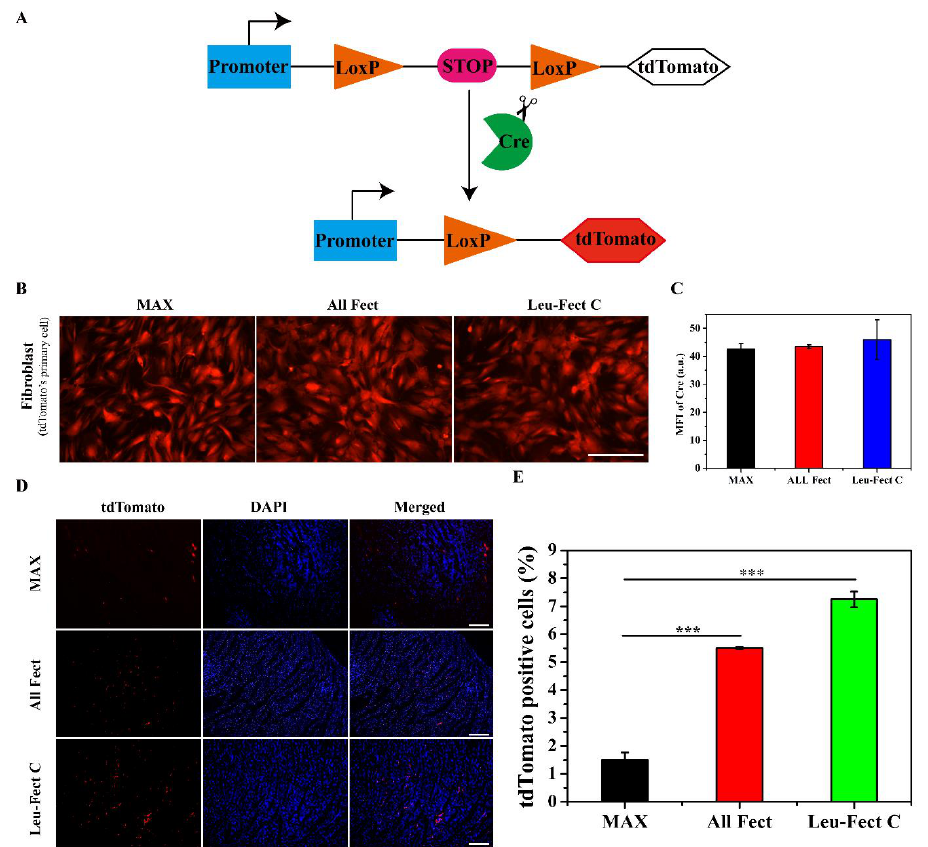
Figure 6. In vivo investigation of local organ injection of modRNA. ( A ) Cre/LoxP system working principle. ( B ) Fluorescent pictures of tdTomato expression following the transfection of Cre modRNA in primary mouse fibroblast cells (scale bar: 200 µm). ( C ) The mean fluorescence intensity of Cre modRNA expression of tdTomato in cells. ( D ) The fluorescent images of tdTomato expression levels in mouse hearts after 3 days of modRNA administration (scale bar: 200 µm). ( E ) Quantitative analysis of tdTomato-positive cell population in hearts. (*** p < 0.001).